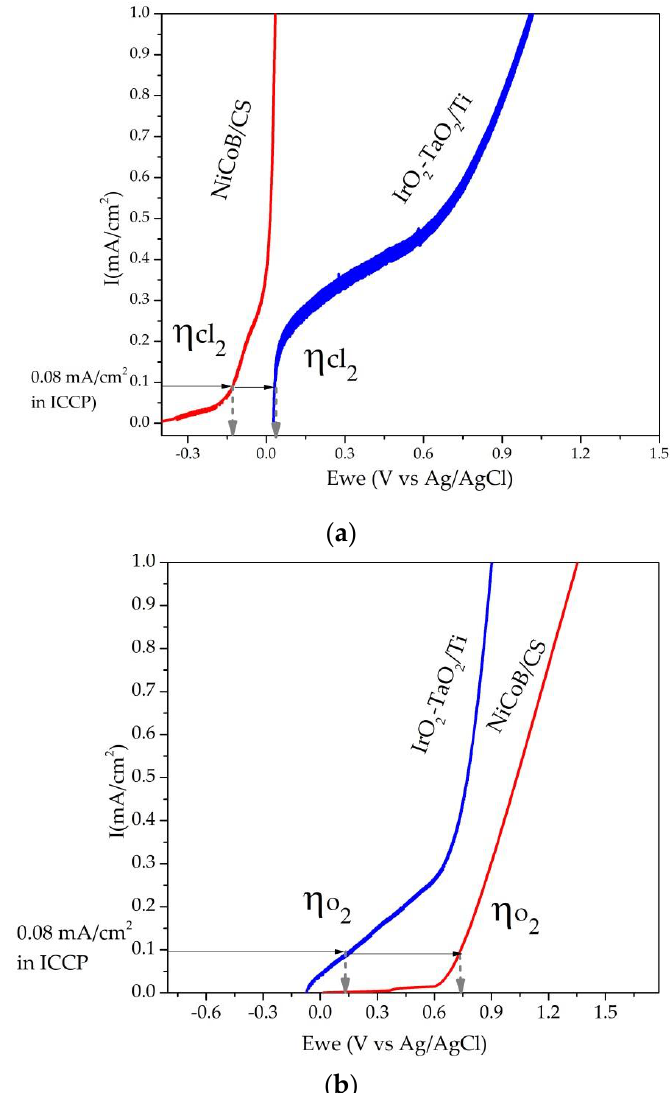
Figure 6. Linear scanning voltammetry curves of the NiCoB/CS and IrO 2 -Ta 2 O 5 /Ti coatings for ( a ) chlorine and ( b ) oxygen evolution.